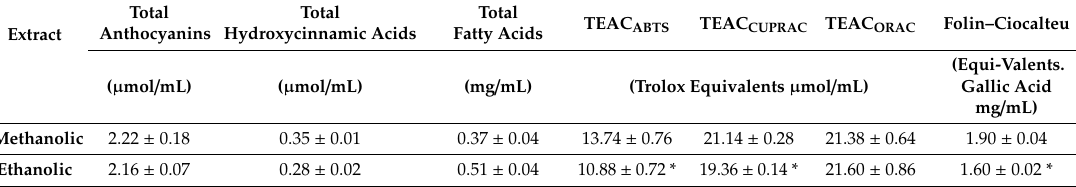
(Equi-Valents. Gallic Acid